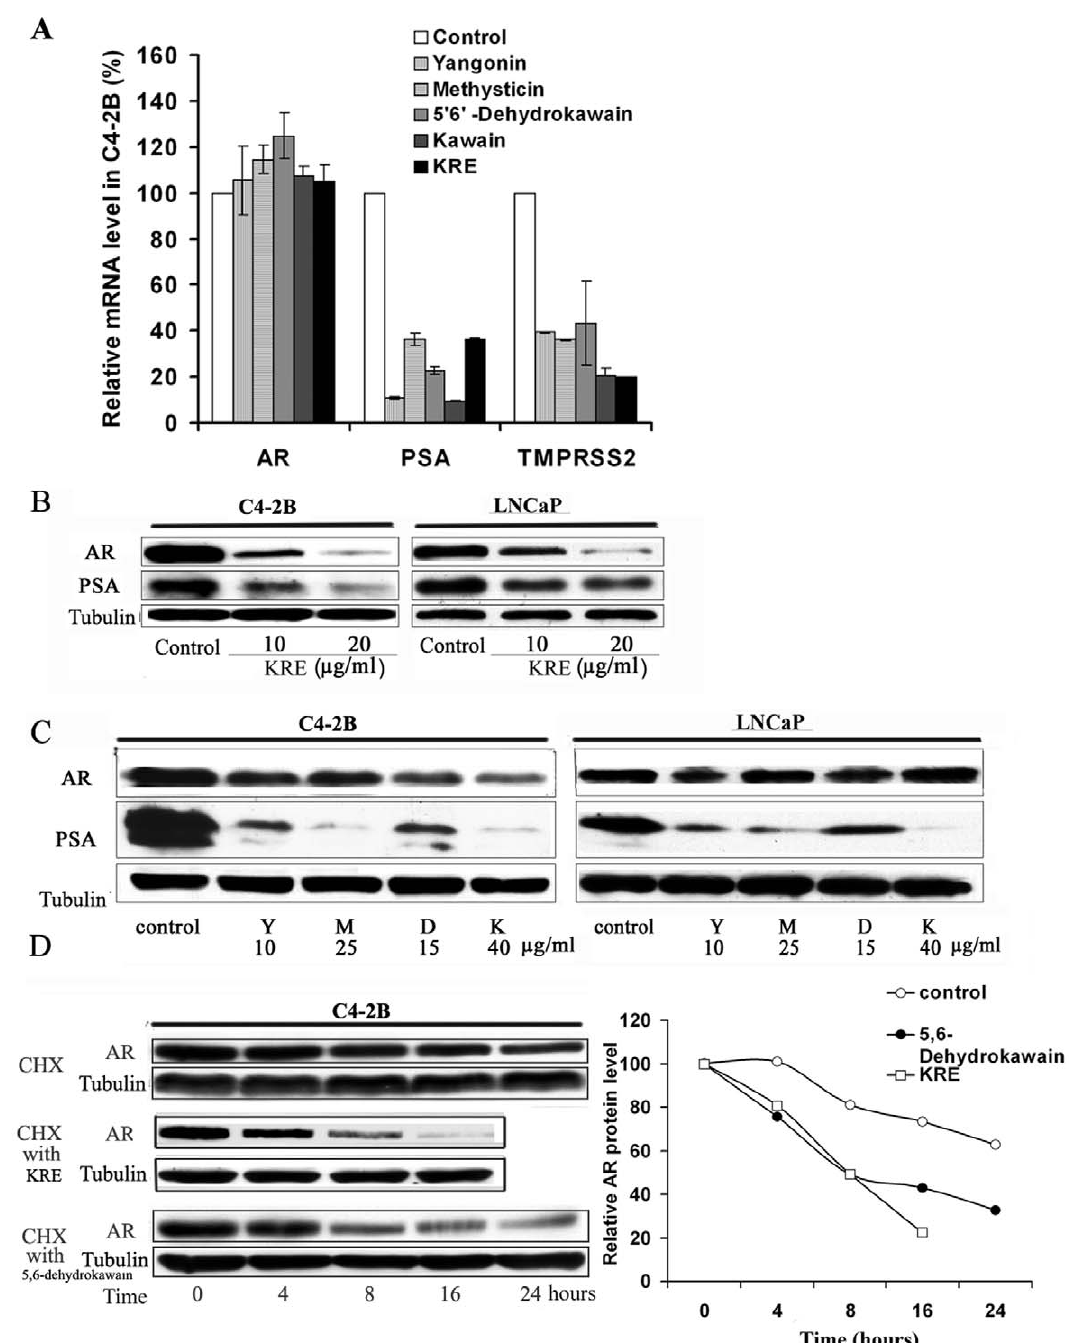
Figure 3. The kava root extract and kavalactones down-regulate expression of AR and AR target genes ( PSA and TMPRSS2 ) via accelerating the degradation of AR protein. ( A ). C4-2B cells were treated with 0.1%DMSO, kava root extract, dehydrokawain, kawain, yangonin and methysticin for 8 hours. mRNA levels of AR and AR target genes ( PSA and TMPRSS2 ) were determined by real-time RT-PCR. Bars are means 6 SD of three independent quantitative measures. Kava root extract and kavalactones significantly decrease mRNA expression of AR target genes (Student t test, P , 0.01) but not that of AR (P . 0.05). ( B ) and ( C ). The protein expression of AR and PSA in LNCaP and C4-2B cells after indicated treatments at a concentration of their IC 50 s for 16 hours was analyzed by Western blot. a -Tubulin was detected as a loading control. A representative blot was shown from three independent experiments. Y=yangonin; M=methysticin; D=5 9 6;-dehydrokawain; K=kawain, KRE=kava root extract. ( D ). C4-2B cells were pretreated with 10 m g/ml cycloheximide for 2 hours and then supplemented with kava root extract or 5 9 6;-dehydrokawain at a concentration of their IC 50 s for different periods of time. After treatments, AR protein levels were analyzed by Western blotting and semi-quantified by densitometry measurement. A representative blot was shown from three independent experiments.